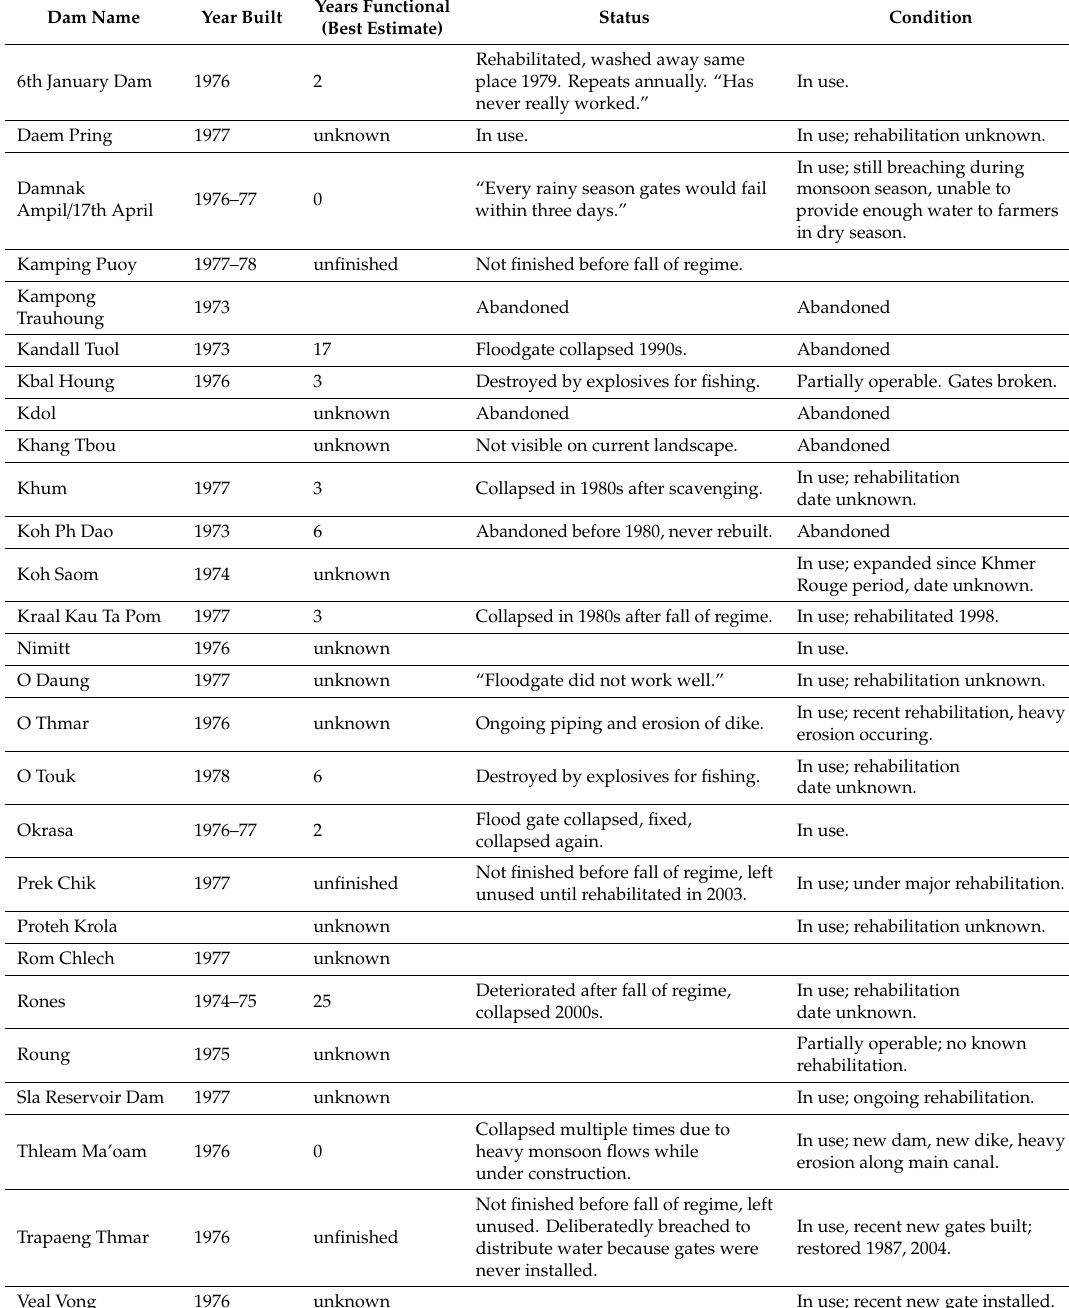
Table 2. List of water storage dams identified, in terms of